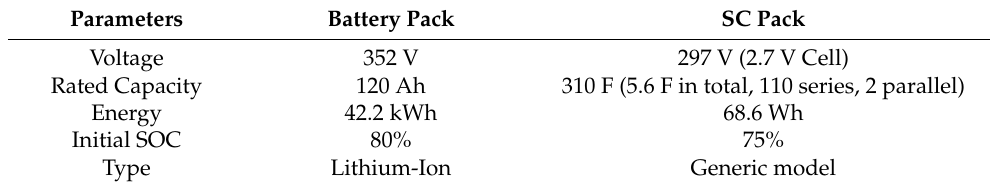
Table 2. Parameter for HESS.